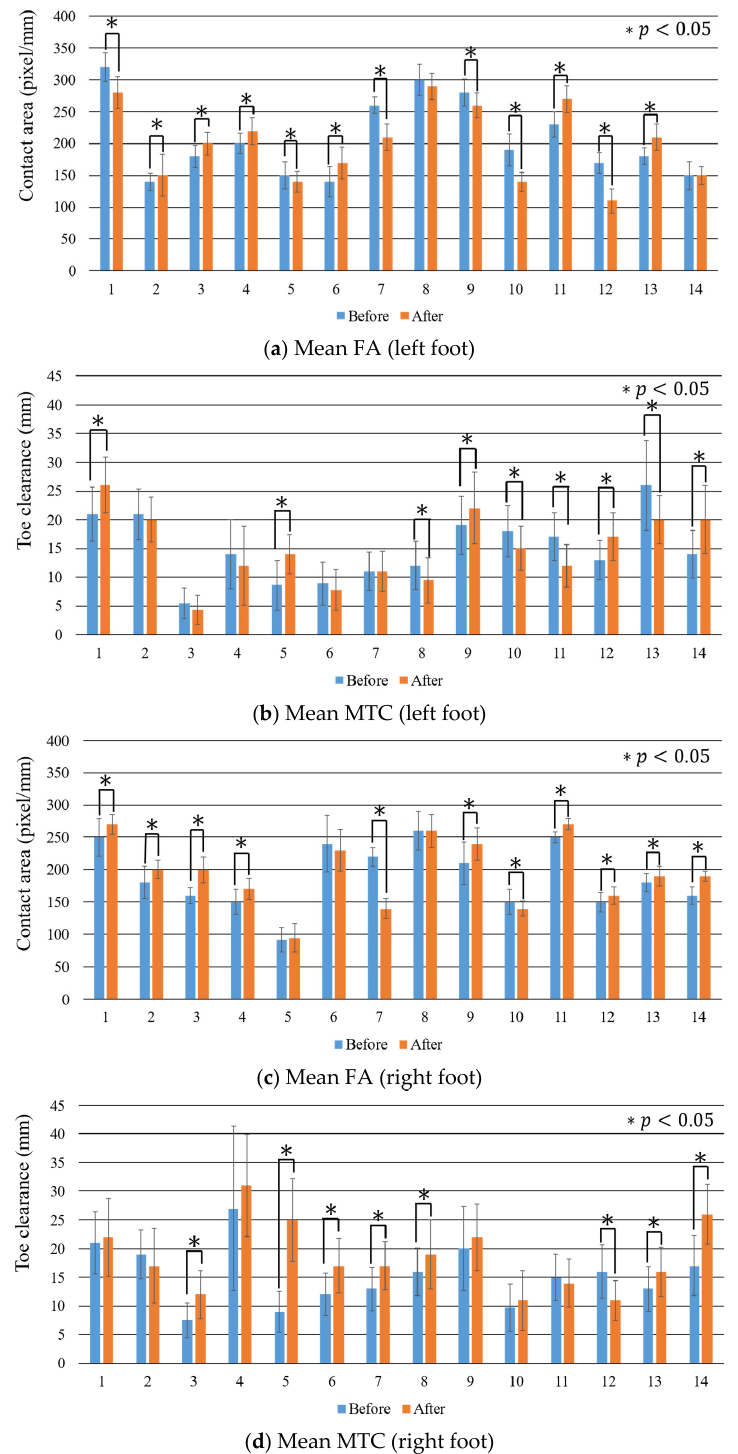
Figure 11. Mean FA and MTC of the individual participants.